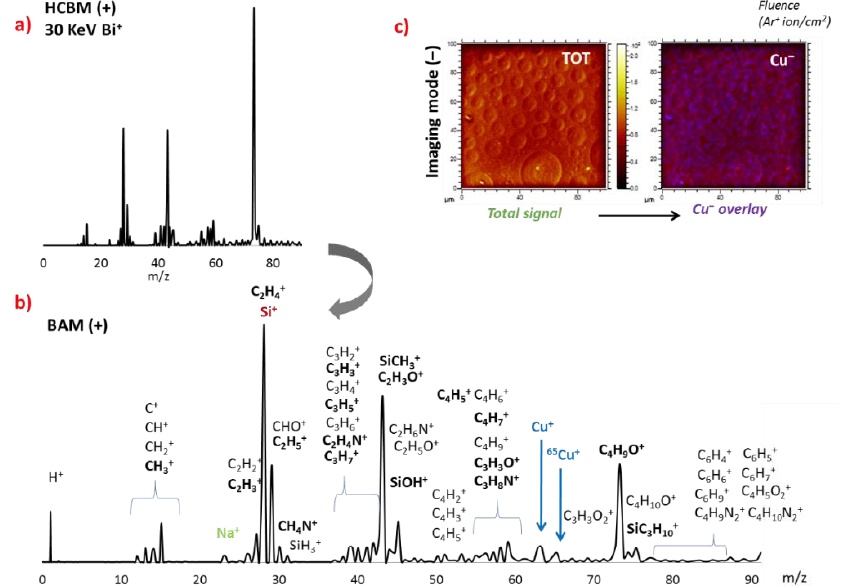
Figure 5. ( a ) 30 KeV Bi + secondary ion mass spectrometry (SIMS) ( + ) spectrum of BF0 recorded in high-current bunch mode (HCBM). ( b ) Burst alignment mode (BAM) with assignment of the most probable fragments of the organic components and metals, highlighting the strongest. ( c ) Surface images obtained in imaging mode ( ‒ ) are also shown and indicate the spatial distribution of the signals arising from the Cu ‒ peaks.